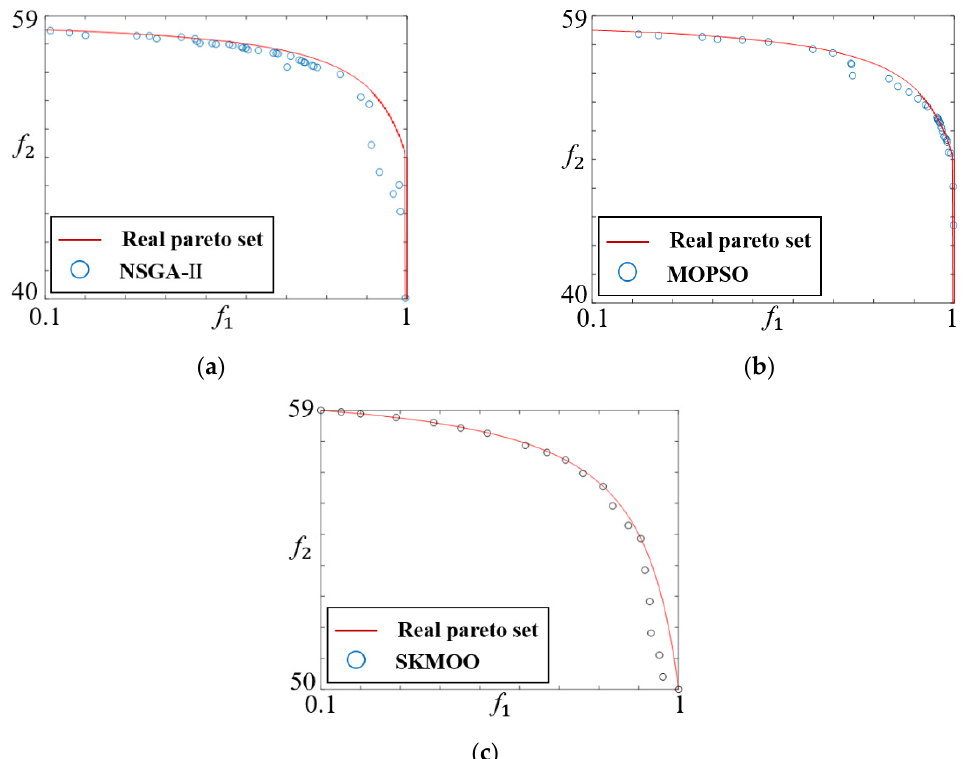
Figure 6. Pareto front set of test function2 ( a ) NSGA-II; ( b ) MOPSO ; ( c ) SKMOO.